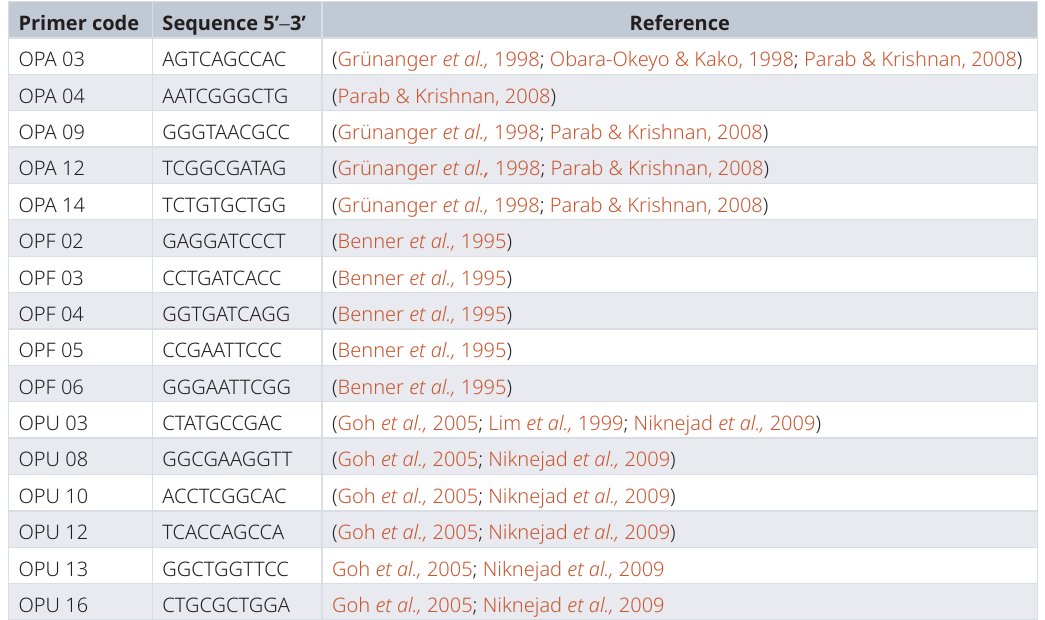
Table 1. RAPD primers used for PCR amplifications. Primer code Sequence 5’ −